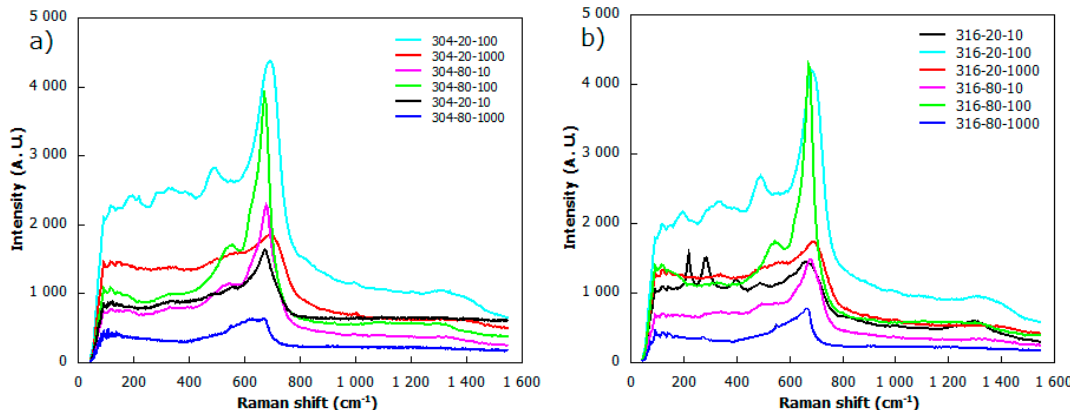
Figure 6. The Raman spectra of laser treated samples for: ( a ) AISI 304; and ( b ) AISI 316 stainless